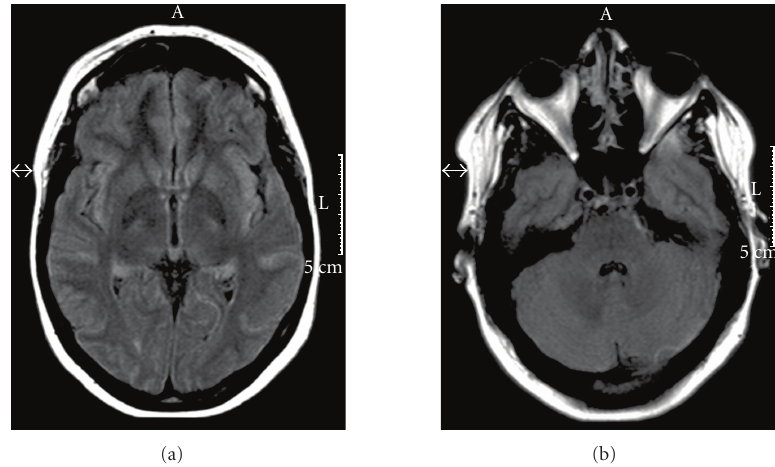
Figure 3: A followup MRI examination three months after admission shows a complete resolution of the vasogenic